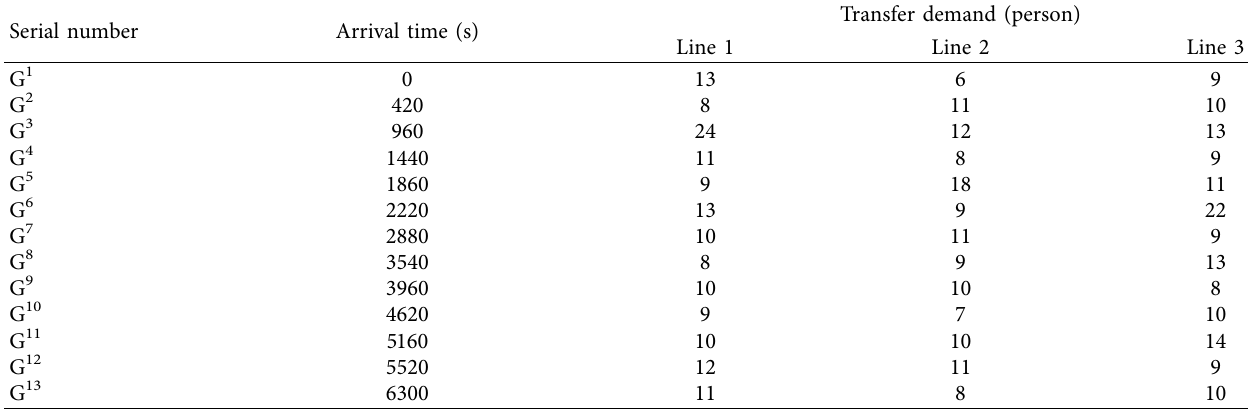
Table 1: Statistics of the arrival time of high-speed railway and the number of passengers transferring to long-distance passenger transport.